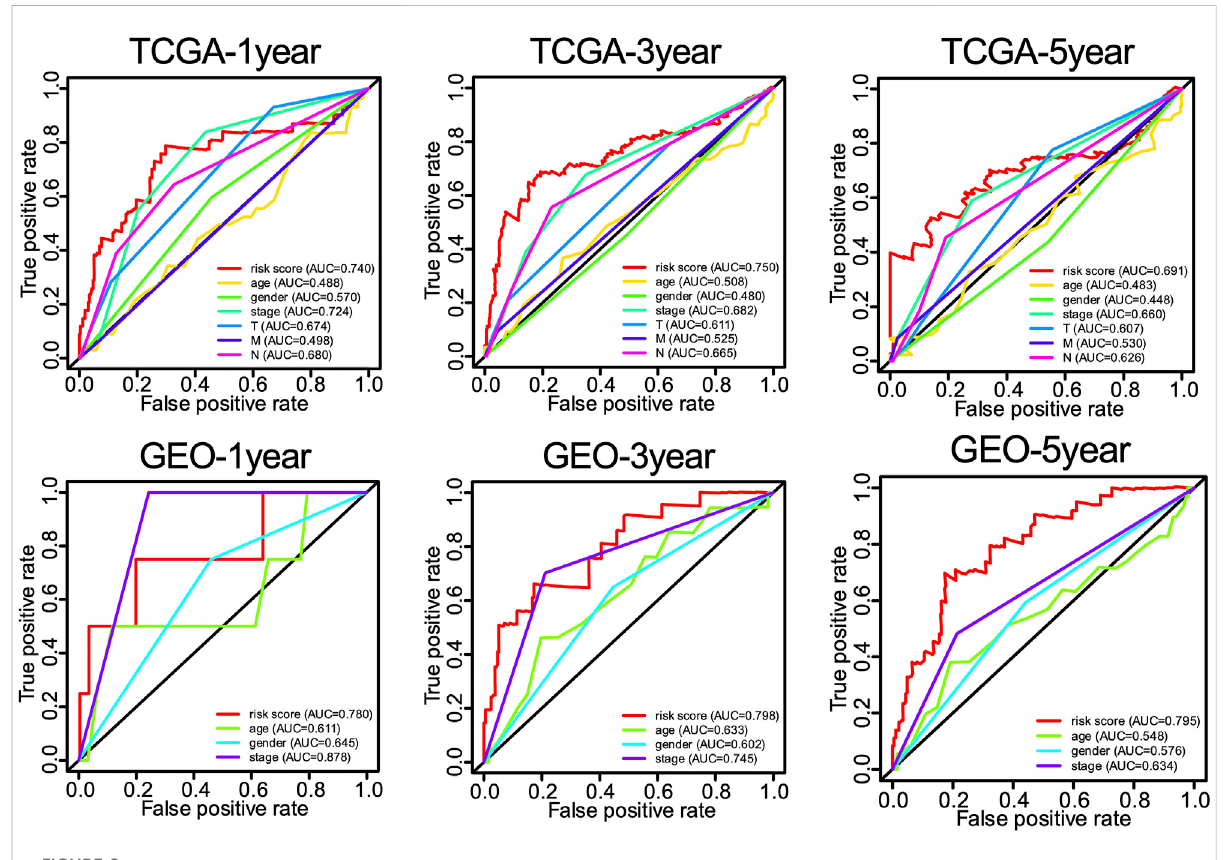
FIGURE 8 The 1-, 3-, and 5-year ROC curves of risk score and related clinical information of LUAD